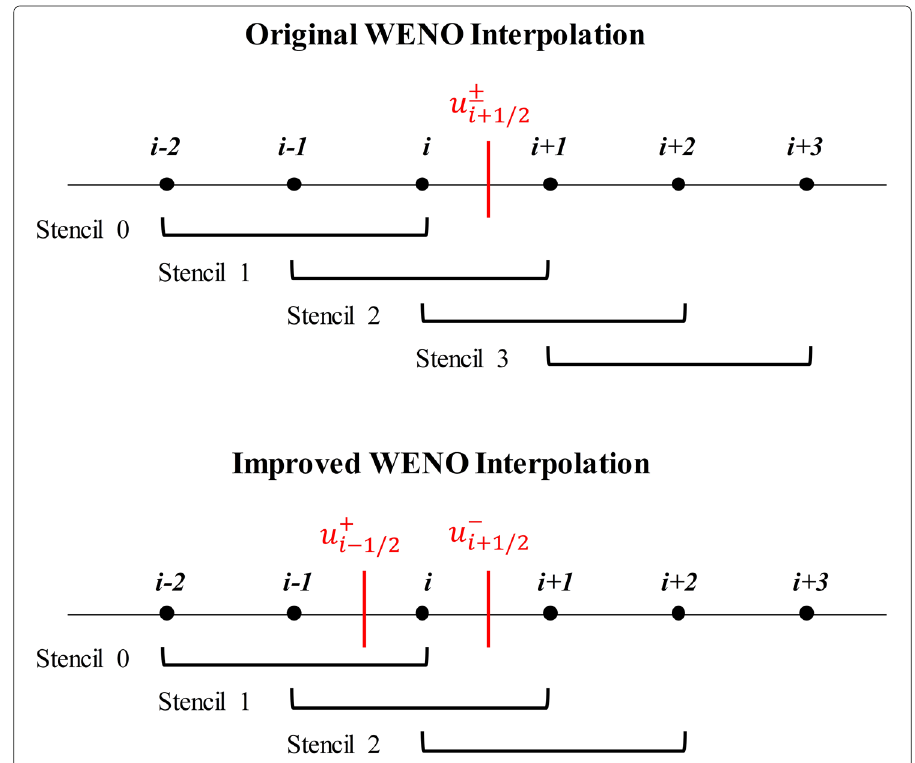
Fig. 10 Comparison of WENO interpolations. In original WENO interpolation, the characteristic space is built are computed simultaneously in a loop. In modified WENO interpolation, the at i + 1 / 2, and u ± i + 1 / 2 characteristic space is built at i , and u − and u + are computed simultaneously in a loop. In modified i + 1 / 2 i − 1 / 2 WENO interpolation, point stencils are the same, so the characteristic variables and smoothness